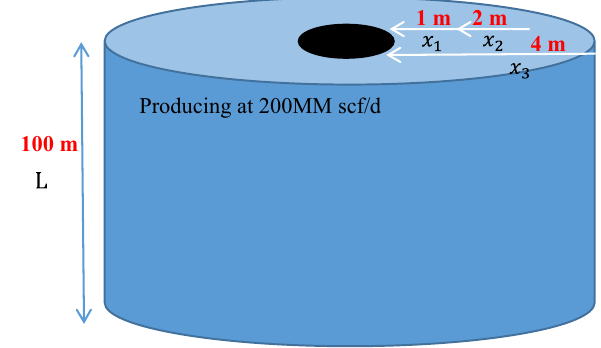
Fig. 2 Sketch of wellbore production interval showing increasing dis- tances away from the wellbore